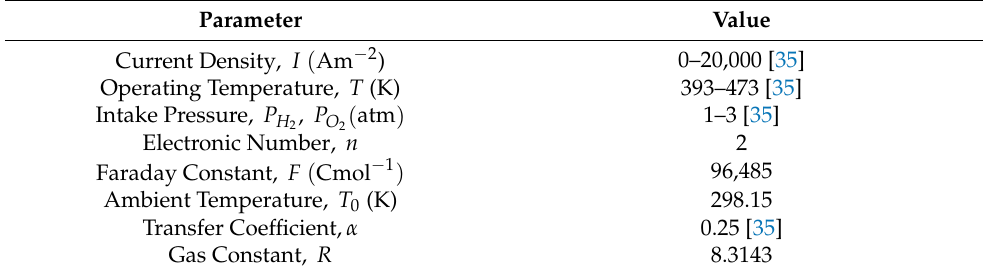
Table 1. Relevant data of HT-PEMFC.